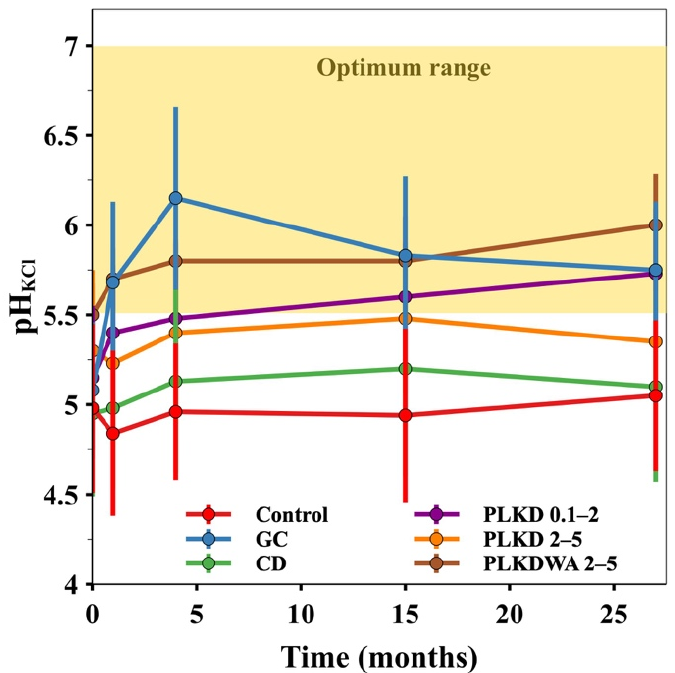
Figure 3. Measured soil pH values of different liming material treatments.